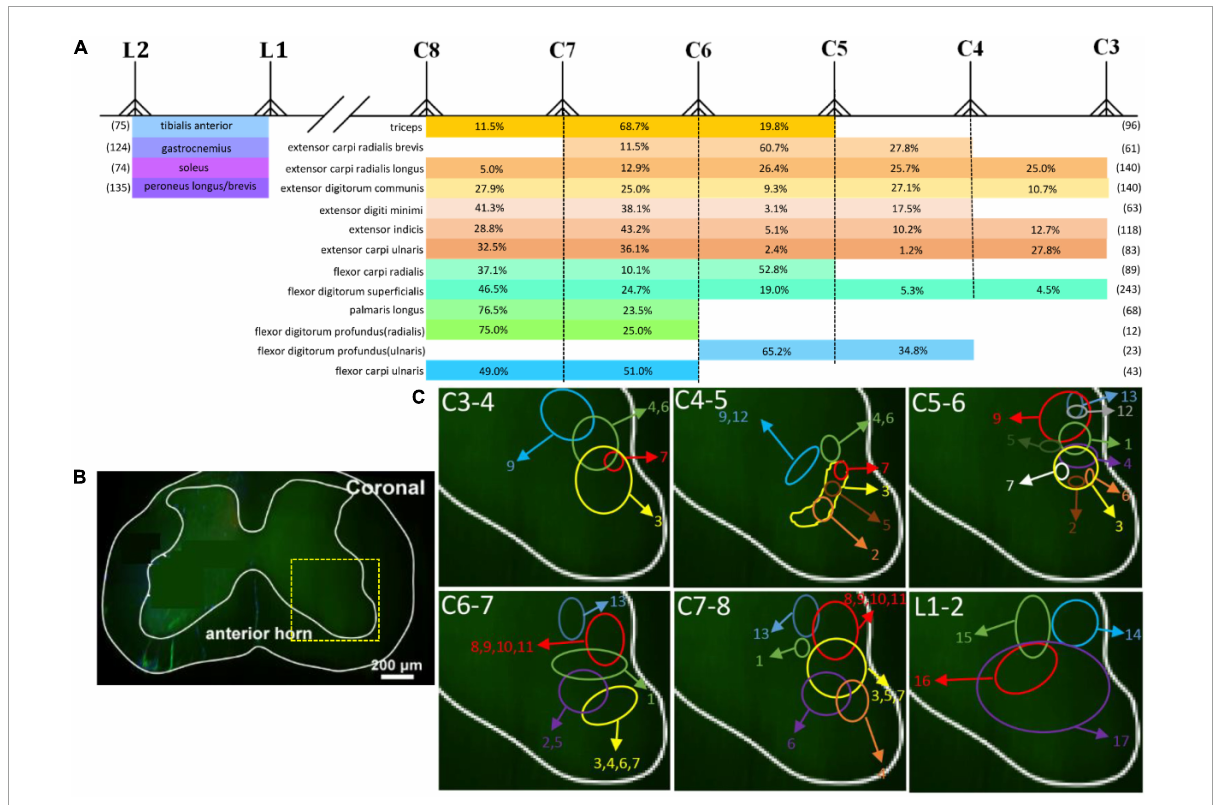
FIGURE8 The spatial location characteristics and the number distribution of different motor neuron pools targeting skeletal muscles in spinal cord. (A) The number distribution of different motor neuron pools. Numbers in parentheses refer to the average total number of motor neurons innervating corresponding muscle. Percentages = number of motor neurons at single segment/total number of motor neurons innervating corresponding single muscle; n = 3 for each muscle. (B) Schematics of a coronal section of the spinal cord. The yellow box that outlines the region of interest is shown in panel (C) . (C) The distribution of different motor neuron columns in the anterior horn of the spinal cord (1: triceps; 2: extensor carpi radialis brevis; 3: extensor carpi radialis longus; 4: extensor digitorum communis; 5: extensor digiti minimi; 6: extensor indicis; 7: extensor carpi ulnaris; 8: flexor carpi radialis; 9: flexor digitorum superficialis; 10: palmaris longus; 11: flexor digitorum profundus (radialis); 12: flexor digitorum profundus (ulnaris); 13: flexor carpi ulnaris; 14: tibialis anterior; 15: soleus; 16: gastrocnemius; 17: peroneus